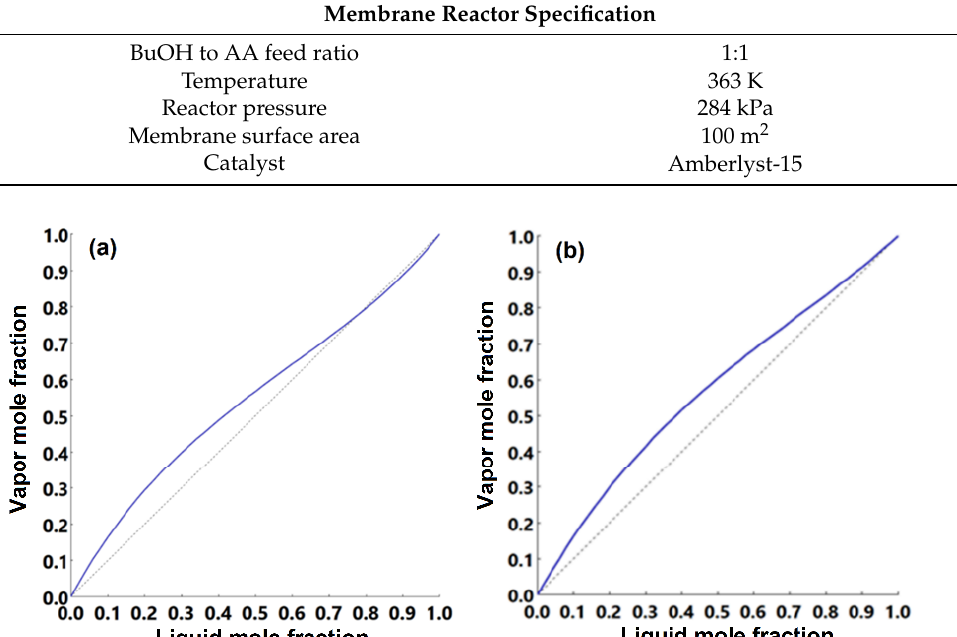
Figure 10. Liquid-phase molar compositions of components inside the extractive distillation column as a function of stage number. Table 4. Stream information of the MR-based process for n -butanol esterification with acetic acid. Stream